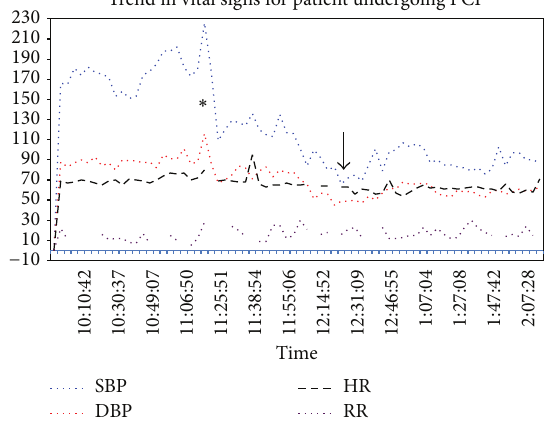
Figure 4: Trend in vital signs during acute aortic dissection. The time of dissection indicated by the asterisk, which is followed by the drop in systolic BP to around 60 (arrow) and the subsequent response to fluid resuscitation.